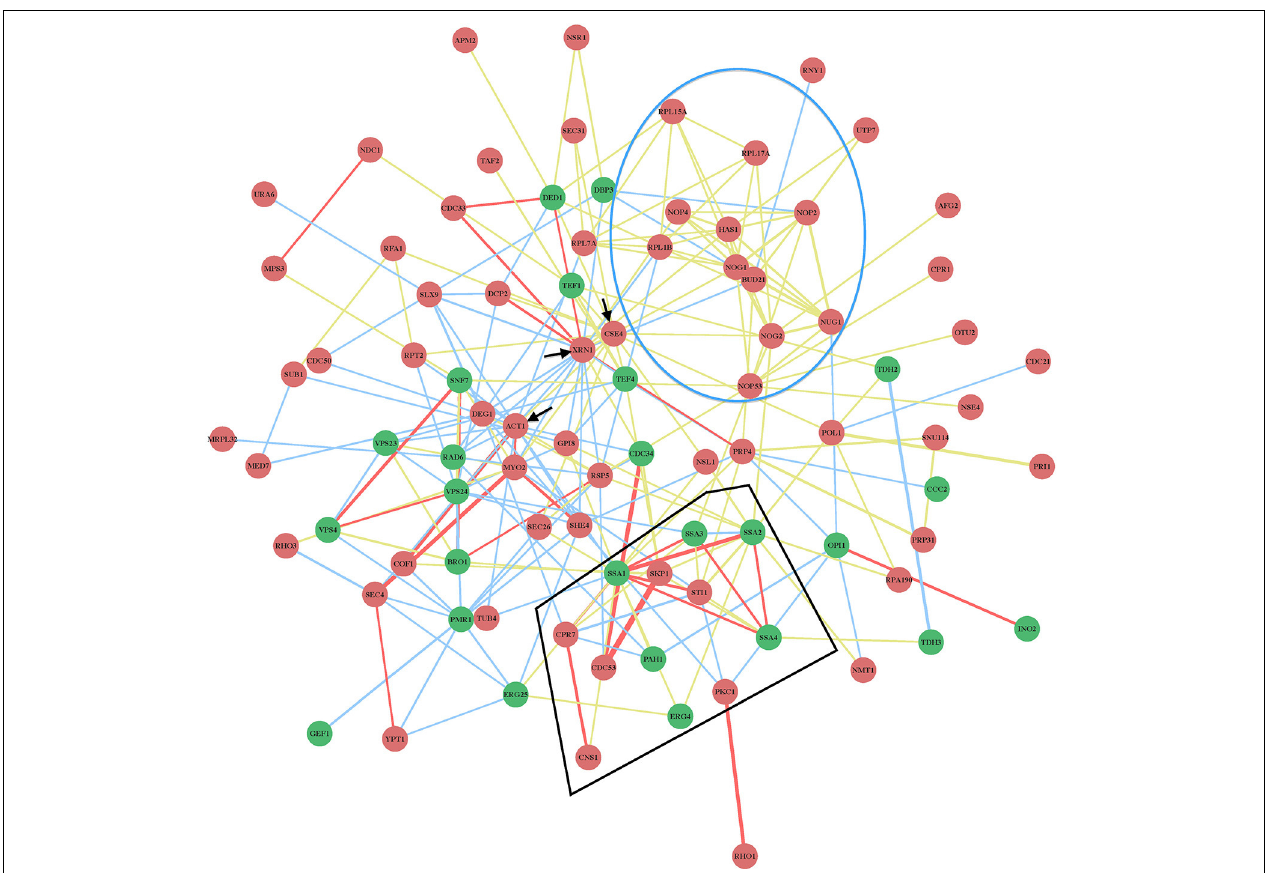
FIGURE 2 | Physical and genetic protein interaction networks of CIRFs and pro-viral host factors in yeast. Functions of the genes are listed in Table 1 . Red nodes indicate inhibitory CIRFs (i.e., viral replication goes up when the gene is deleted or down-regulated); Green nodes show positive pro-viral host factors (viral replication decreases when the gene is deleted or down-regulated); yellow lines indicate physical interactions; blue lines mark genetic interactions; red lines show both physical and genetic interactions. The thicker the line between two nodes, the greater the confidence of the interaction is. This means that there are more experimental data supporting the existence of the particular interaction.